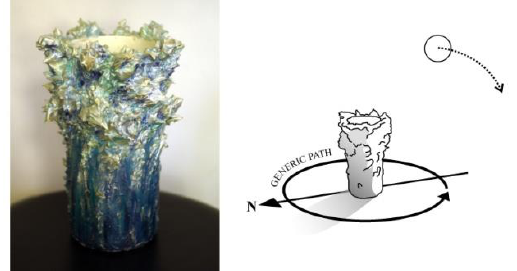
Figure 5. Left, the surveyed vessel; right, orientation of capture sequences.